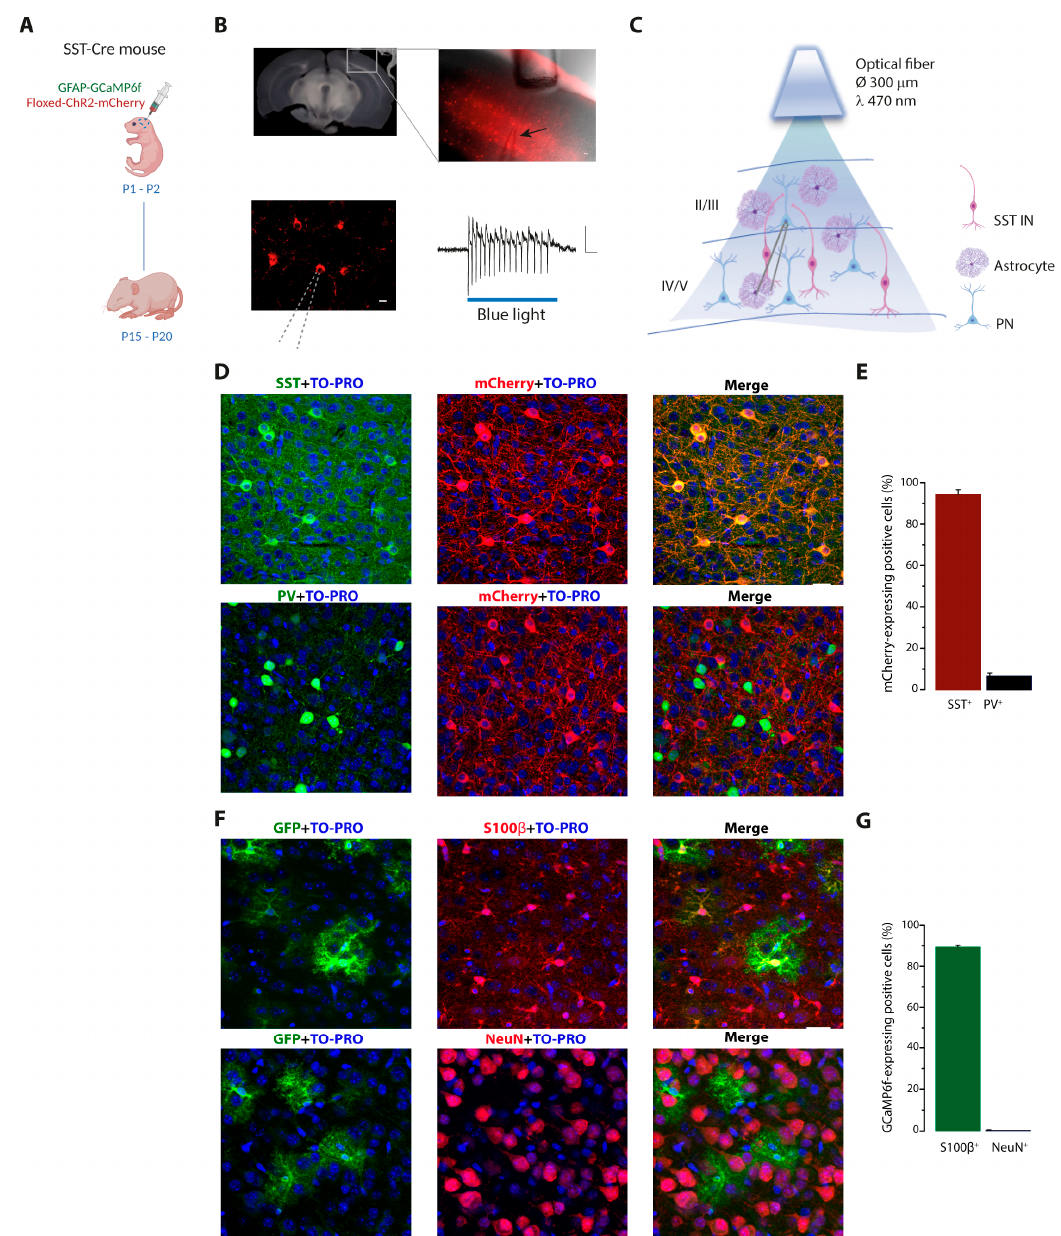
Figure 1. Experimental approach for Channelrhodopsin-2 (ChR2)-mCherry specific expression in somatostatin (SST) interneurons and GCaMP6f specific expression in astrocytes from the visual cortex (VCx). ( A ) Schematic representation of adeno-associated virus (AAV) injections in the VCx of newborn SST Cre mice and brain slice preparations at least 2 weeks after injections. ( B ) Left upper panel, representative differential interference contrast (DIC) image of a coronal slice containing the VCx (square). Right upper panel, combined fluorescence and DIC images of the square shown in left panel, showing ChR2-mCherry expression in VCx SST interneurons, the optical fiber for optogenetic stimulation, and the patch pipette (arrow) for electrophysiological recordings. Scale bar, 50 µ m. Bottom, fluorescence image of ChR2-mCherry-expressing SST interneurons (scale bar, 10 µ m) and a representative action potential discharge, recorded in cell-attached mode, upon a single 150 ms blue light (470 nm) pulse stimulation. Scale bars, 20 ms, 20 pA. ( C ) Schematic of the experimental approach. Ca 2+ imaging in layer II/III astrocytes and whole-cell patch-clamp recordings from layer II/III pyramidal neurons (PNs) were performed before and after optogenetic stimulation of SST interneurons. In this figure and the other figures, violet-shaped cells represent astrocytes, red cells represent SST interneurons, and